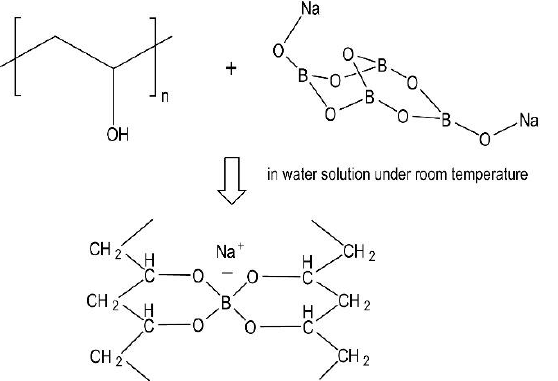
Figure 6. Crosslinking reaction equation of PVA.